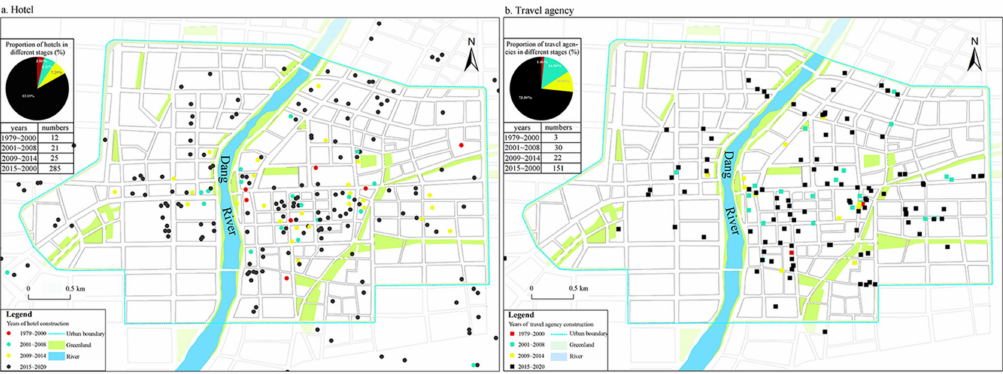
Figure 9. The spatial distribution of hotels and travel agencies in the four evolution